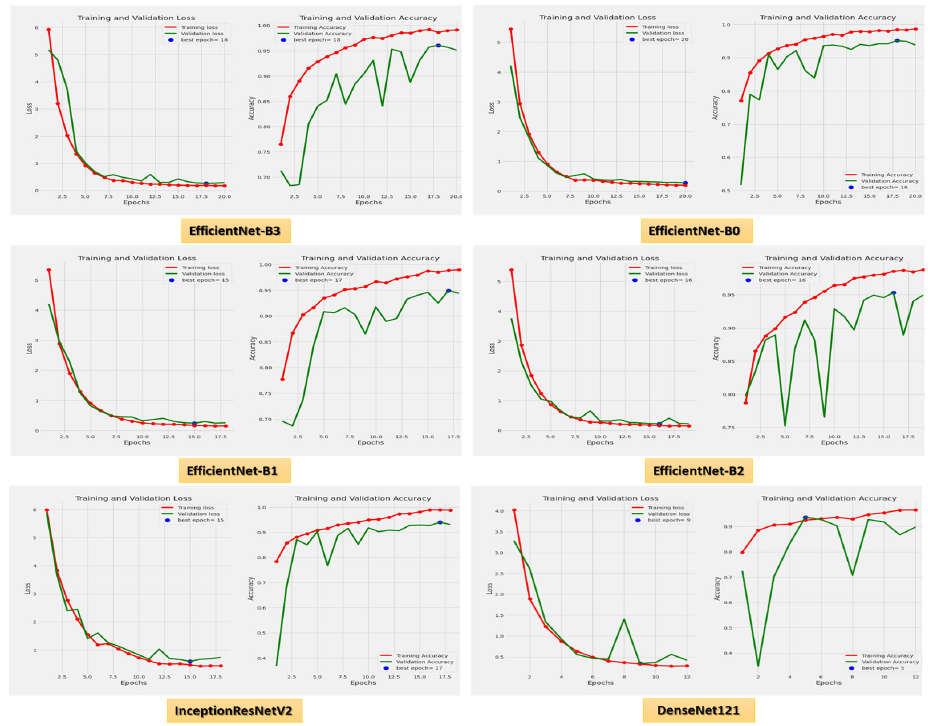
Figure 8. The loss and accuracy curves for the six CNN models using dynamic LR.